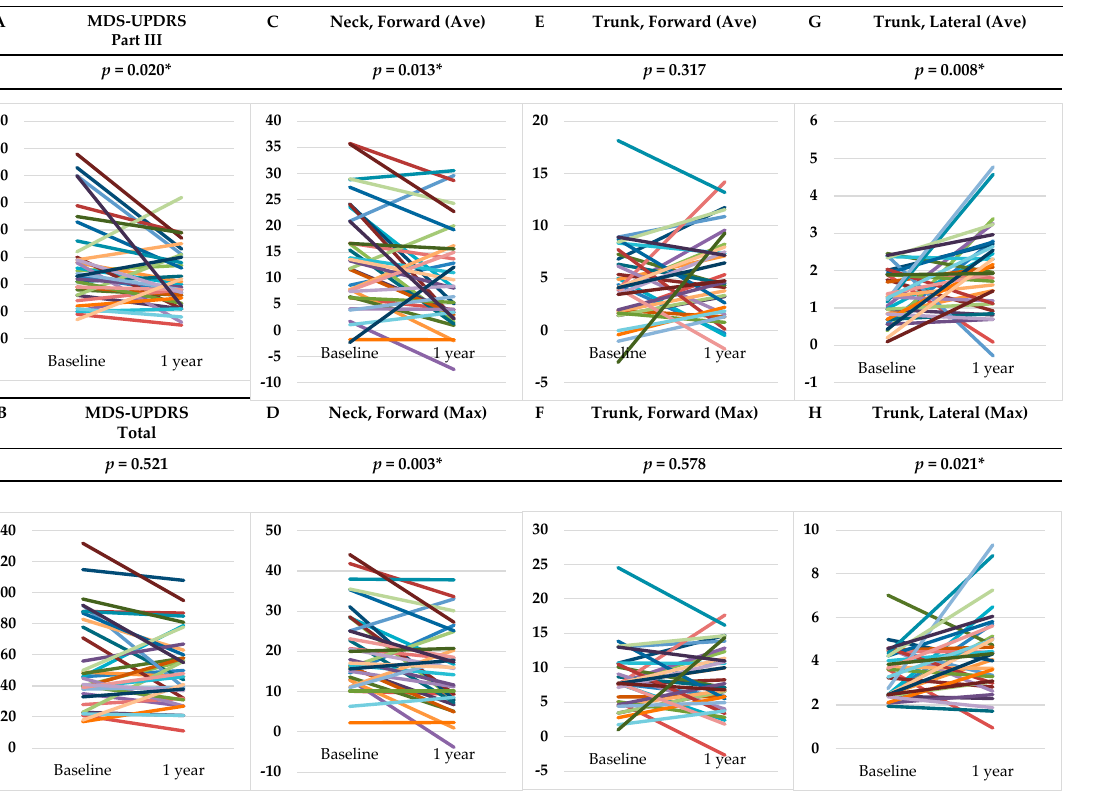
Figure 3. Changes over time in MDS-UPDRS Part III/Total score and tilt angles: ( A ) MDS-UPDRS Part III subtotal score; ( B ) MDS-UPDRS total score; ( C ) mean forward tilt angle of the neck; ( D ) maxi- mum forward tilt angle of the neck; ( E ) mean forward tilt angle of the trunk; ( F ) maximum forward tilt angle of the trunk; ( G ) mean lateral tilt angle of the trunk; and ( H ) maximum lateral tilt angle of the trunk. * p <